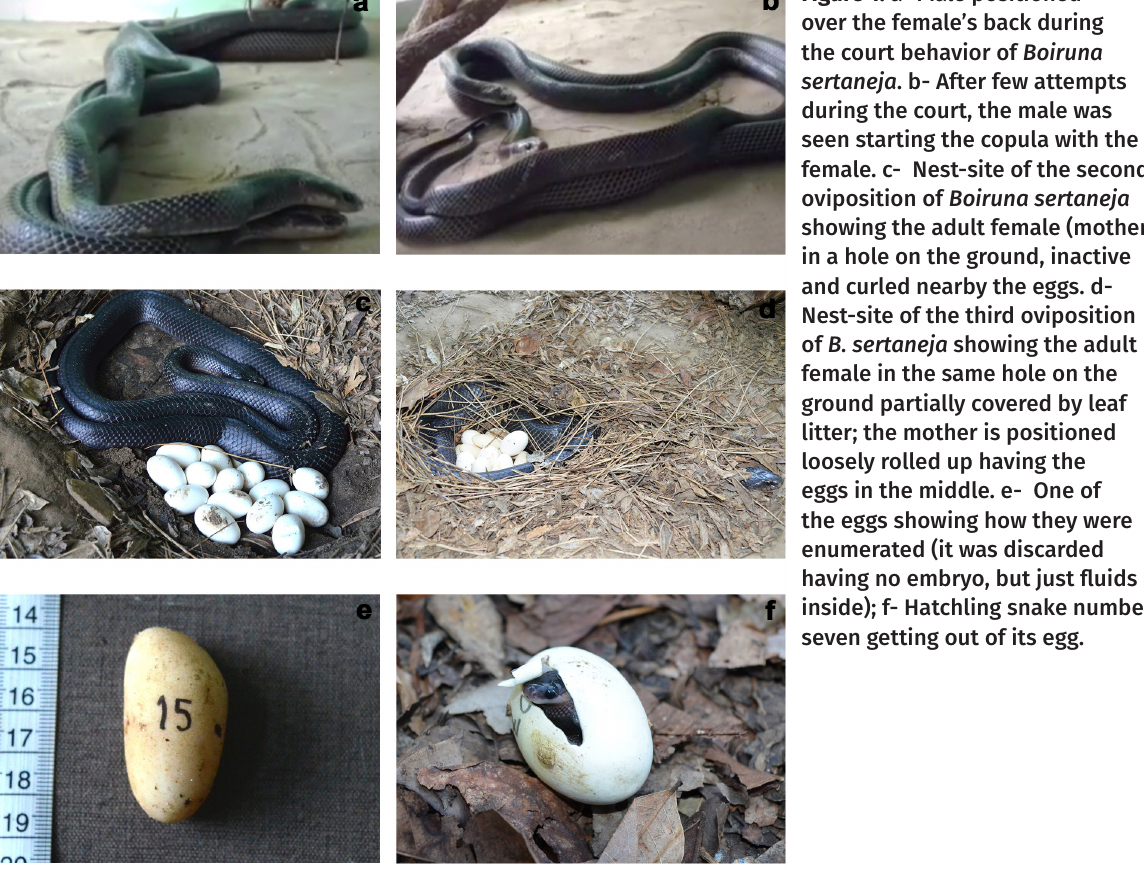
Figure 1. a- Male positioned over the female’s back during the court behavior of Boiruna sertaneja . b- After few attempts during the court, the male was seen starting the copula with the female. c- Nest-site of the second oviposition of Boiruna sertaneja showing the adult female (mother) in a hole on the ground, inactive and curled nearby the eggs. d- Nest-site of the third oviposition of B. sertaneja showing the adult female in the same hole on the ground partially covered by leaf litter; the mother is positioned loosely rolled up having the eggs in the middle. e- One of the eggs showing how they were enumerated (it was discarded having no embryo, but just fluids inside); f- Hatchling snake number seven getting out of its